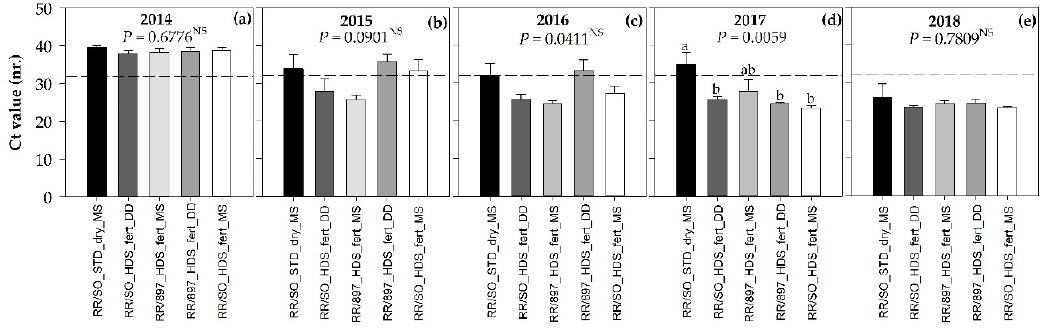
Figure 2. Candidatus Liberibacter asiaticus ( C Las) DNA in “Ray Ruby” grapefruit (RR) trees expressed in terms of normalized cycle threshold (Ct) values from 2014 to 2018 ( a – e ). Trees were considered positive when C t values were ≤ 32 (indicated by the dashed horizontal line). Treatments: RR / SO_STD_dry_MS = Sour Orange (SO) rootstock + standard spacing (STD, 358 trees per ha) + dry granular fertilizer + microsprinkler (MS), RR / SO_HDS_fert_DD = SO rootstock + high density staggered (HDS, 953